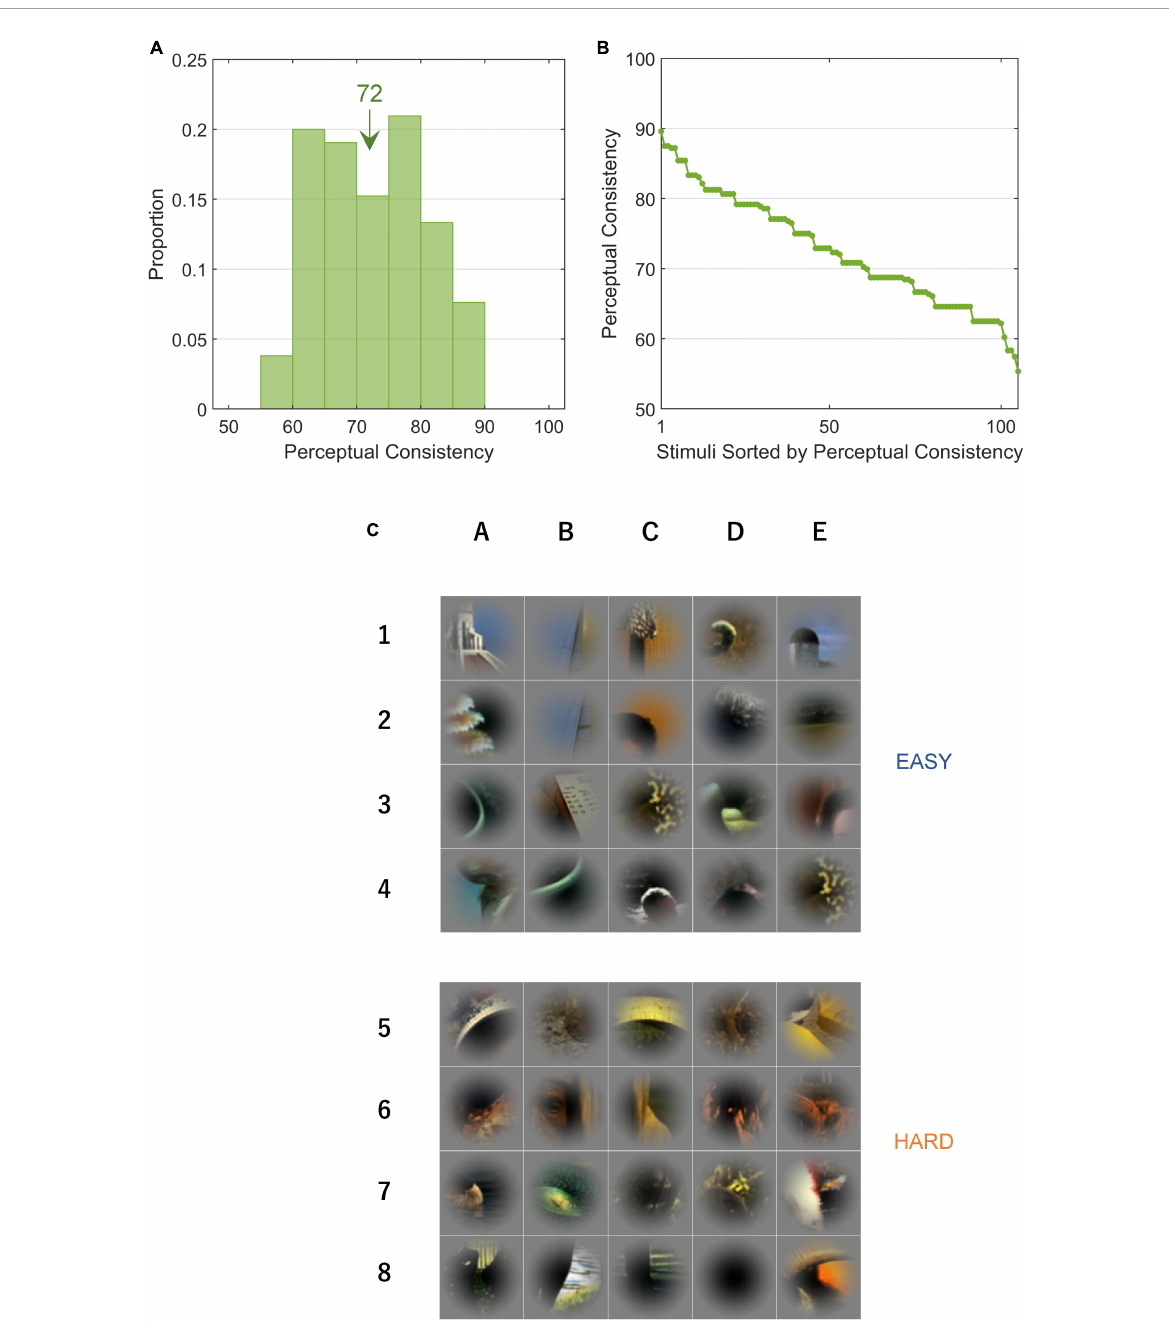
be slightly greater than those with the HARD stimulus